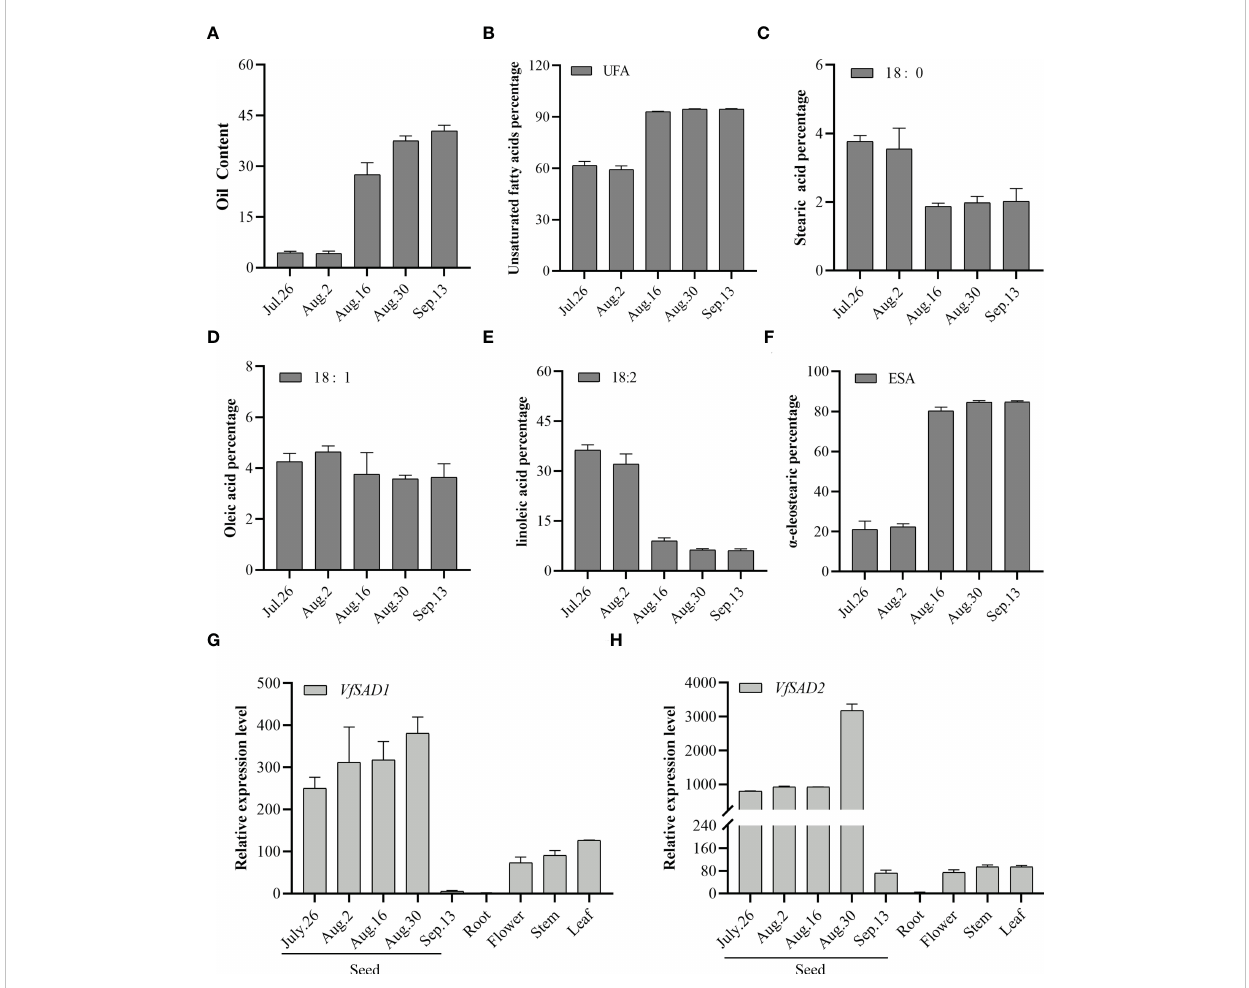
FIGURE 2 Oil content in the developing seed and the expression level of the two SAD genes in the multiple tissues of tung tree. (A) Oil content in the seeds from multiples development stages; (B – F) percentage of unsaturated fatty acid (B) , stearic acid (C) , oleic acid (D) , linoleic acid (E) , and a -eleostearic (F) in the seeds from multiples development stages; (G, H) the relative expression level of VfSAD1 (G) and VfSAD2 (H) in the different tissues of tung tree. The error bar represents the standard deviation (± SD) for setting three biological